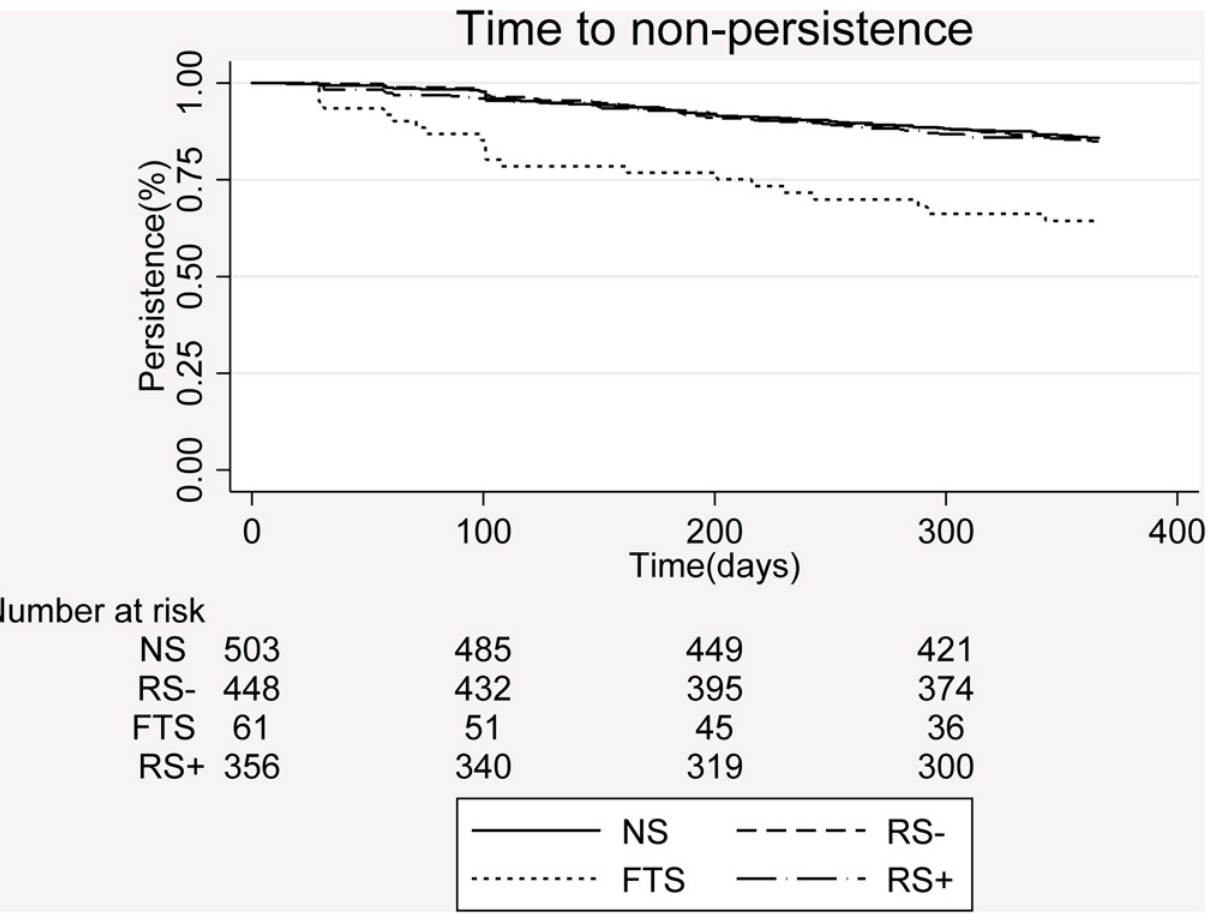
Fig 2. Kaplan-Meier plots of time to non-persistence having switched generics or not. NS : Never Switchers, RS- : Recurrent Switchers without generic switch on index day, FTS : First Time Switchers and RS+ : Recurrent Switchers with generic switch on index day.